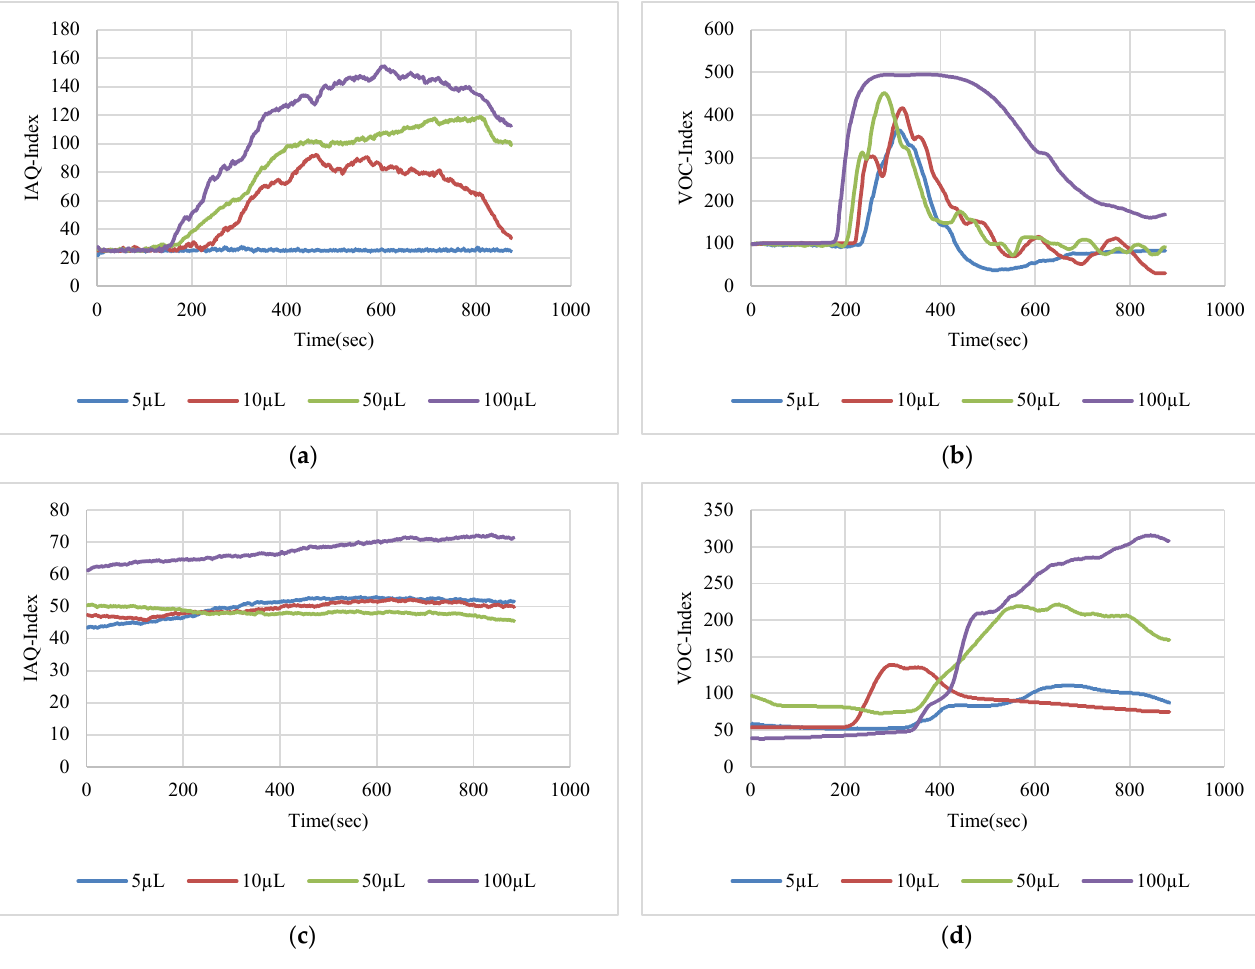
( b ) Figure 21. ( a ) SGP41 step response time T90 for NOx gases, ( b ) SGP41 recovery time for NOx gases.